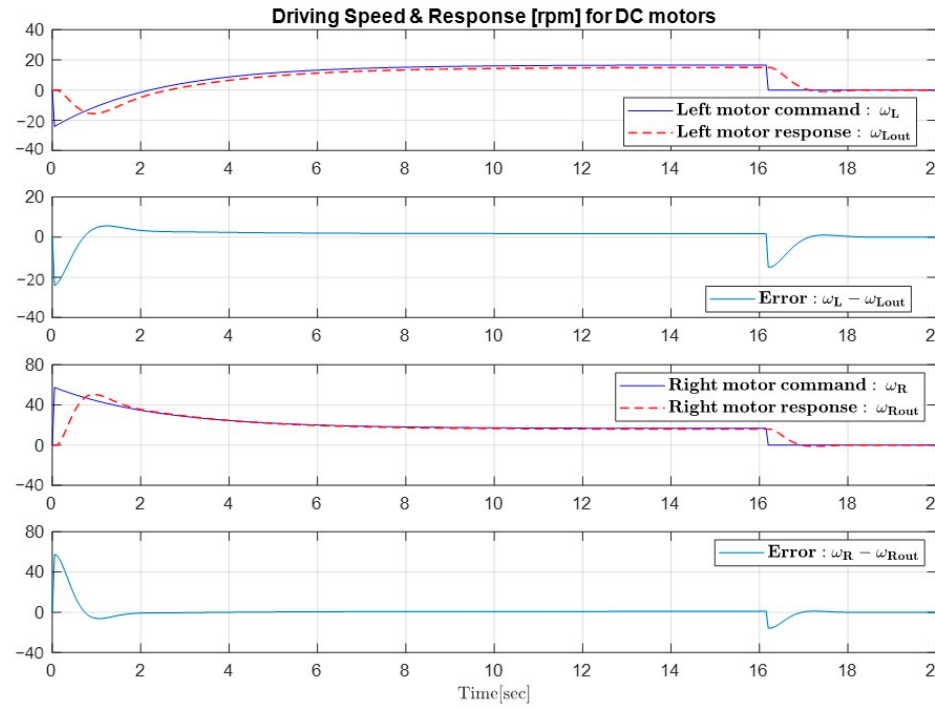
Figure 20. Experiential results of Case II: motor speed commands vs. resulting outputs.